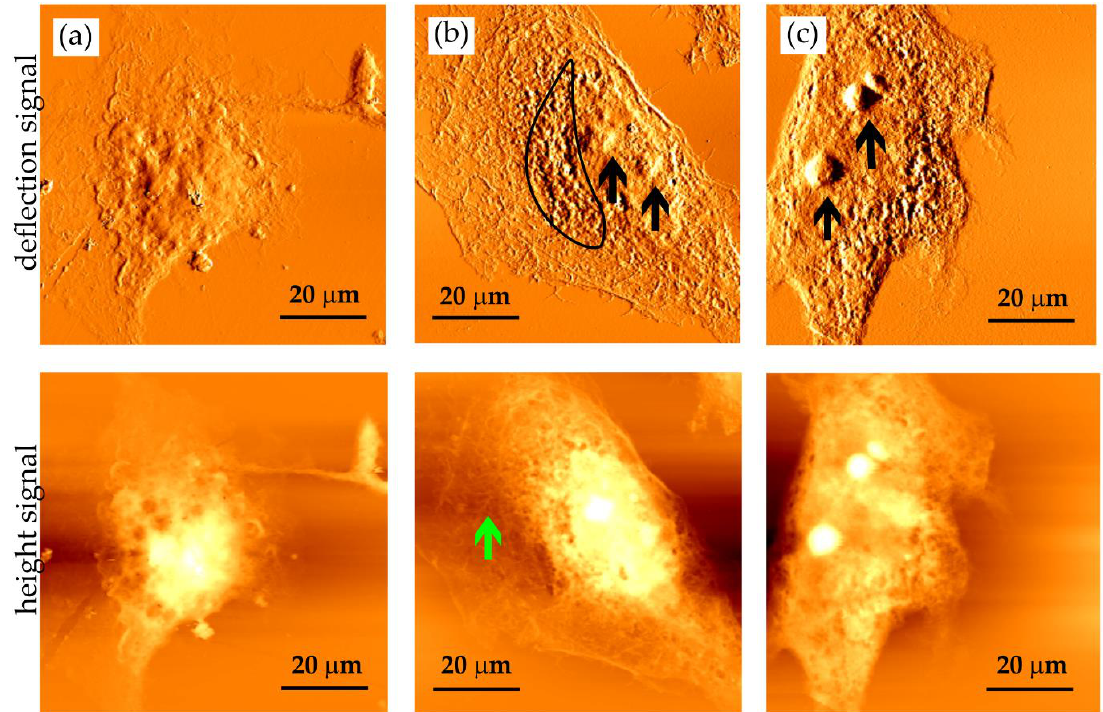
Figure 6. AFM images of cellular imprints of fixed HCC38 breast cancer cells saved in PMMA photoresists by soft X-ray contact microscopy. Images were obtained with SXR exposure of ( a ) 400, ( b ) 600, and ( c ) 800 pulses. Imprints were recorded by AFM working in contact mode (Xe120, Park Systems) with OTR4 cantilevers (0.02 N/m, Bruker). Scan size of 80 × 80 µm 2 . Two types of signal are presented: deflection ( top panel) and height ( bottom panel).